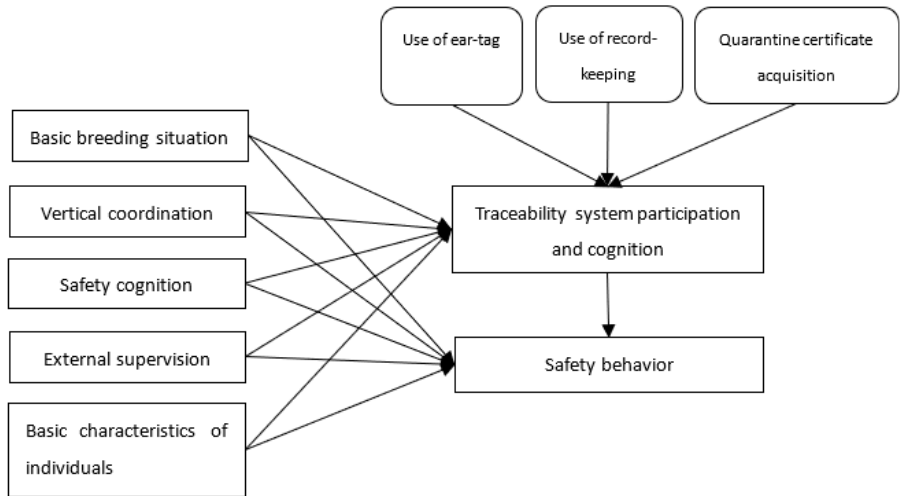
Figure 1. Theoretical model framework.